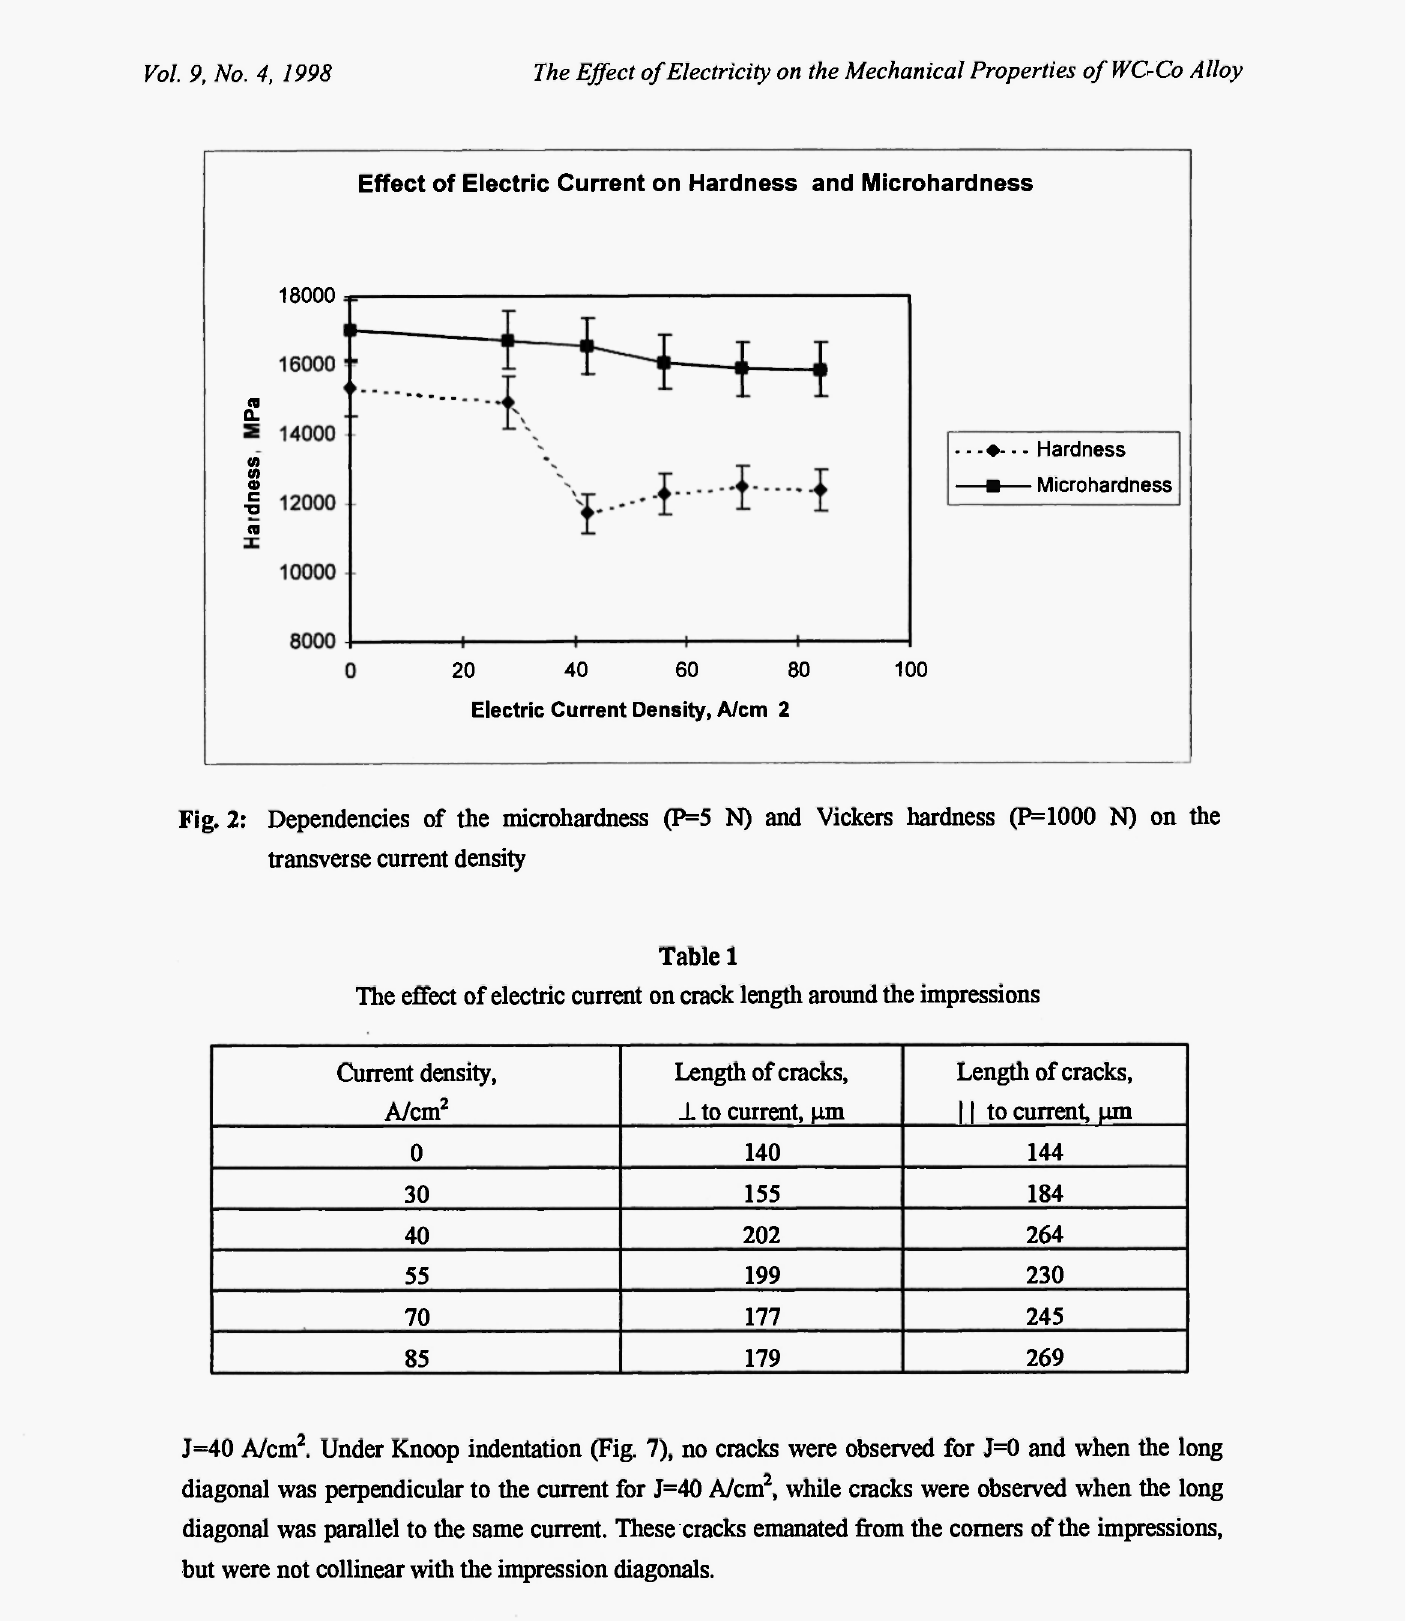
The effect of electric current on crack length around the impressions Current density, Length of cracks, Length of cracks, A/cm 2 _L to current, μιη 11 to current,